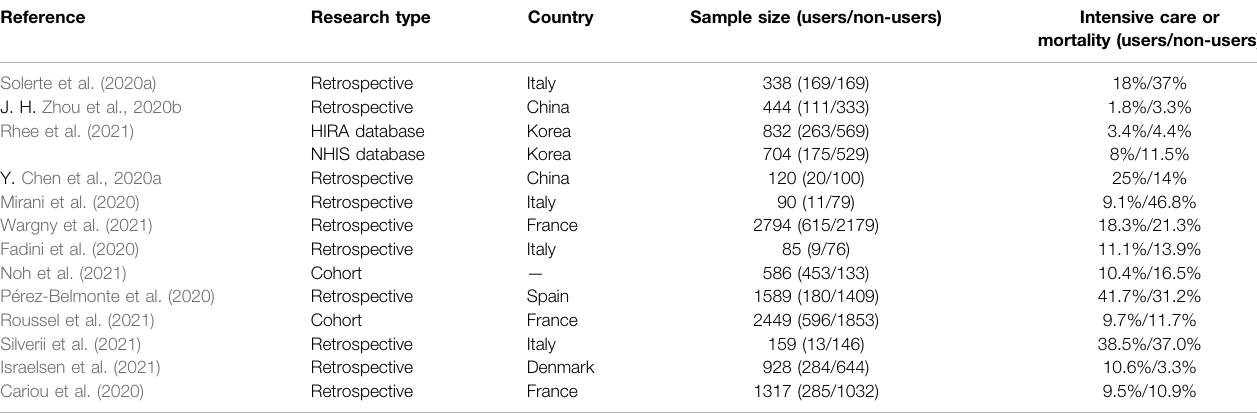
TABLE 1 | Clinical outcomes of DPP4 inhibitors in COVID-19 patients with T2DM.